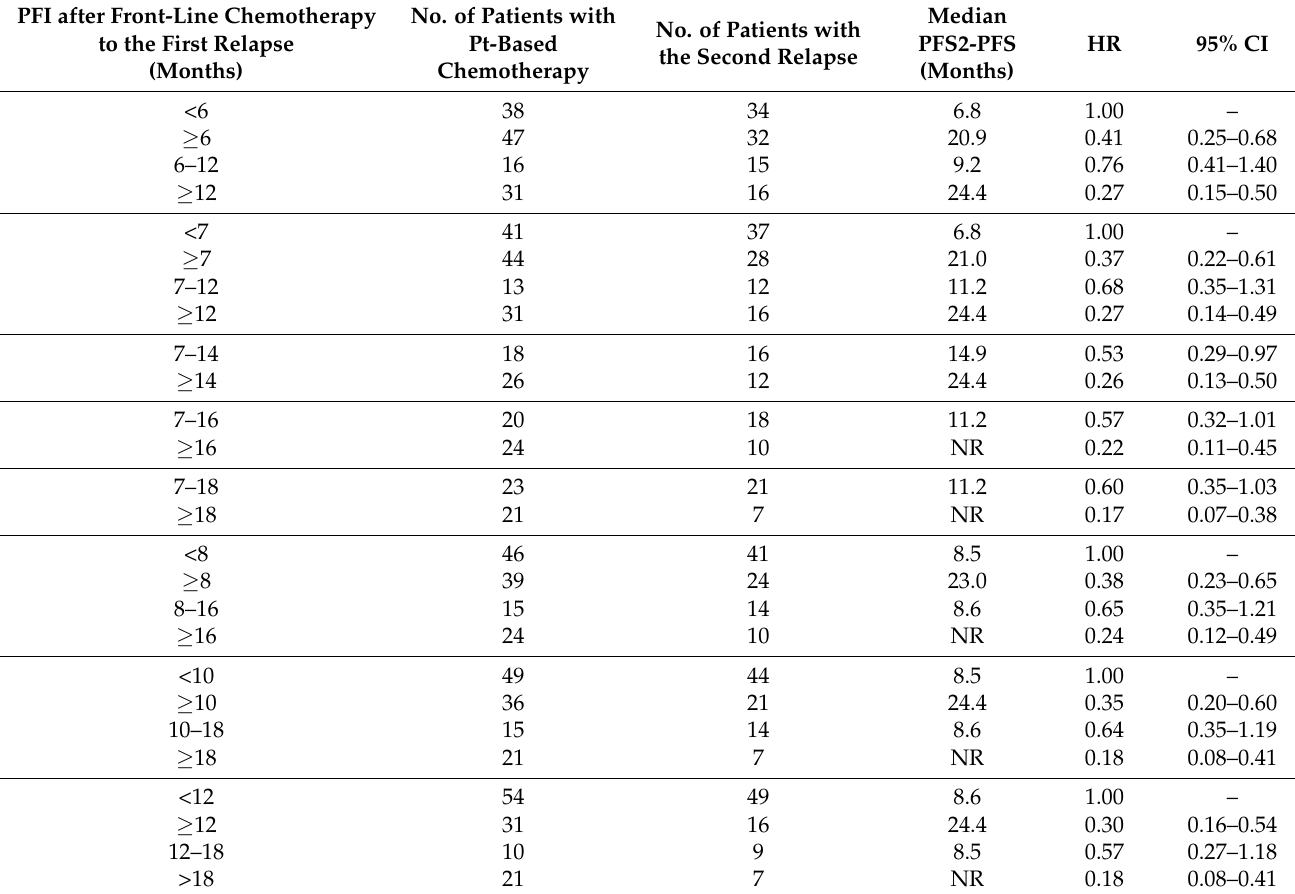
Table 2. Degree of platinum sensitivity in OCCC patients treated with a platinum-based regimen according to the interval from the end of first-line treatment to the first relapse ( n =